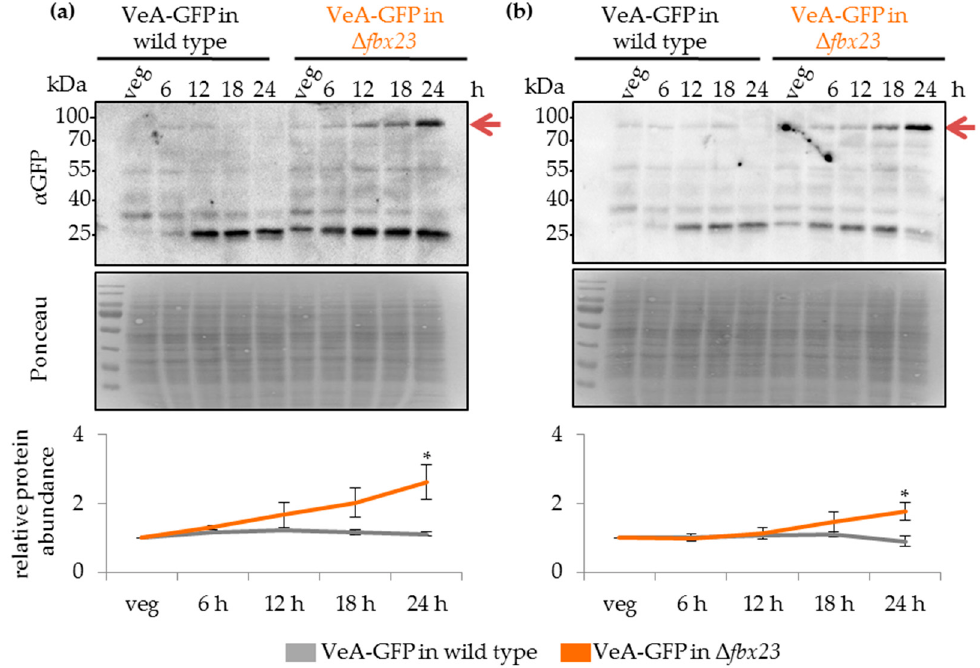
Figure 9. Fbx23 prevents VeA-GFP accumulation during the late stages of multicellular development. Strains were grown in submerged culture for 20 h at 37 ◦ C (veg) and shifted onto solid agar plates containing equal amounts of minimal media. Plates were incubated for 24 h at 37 ◦ C in light or in darkness to induce asexual ( a ) or sexual ( b ) development, respectively. Samples were taken every six hours. Protein crude extracts were prepared to analyze the abundance of VeA-GFP fusion protein during developmental stages in wild type or ∆ fbx23 strain. Signals of VeA-GFP fusion protein were normalized against Ponceau staining of the nitrocellulose membrane. Quantification results of four biological replicates are shown. The standard error of the mean is shown. Significances were calculated with the t -test, always compared to the protein amount during vegetative growth (* p ≤